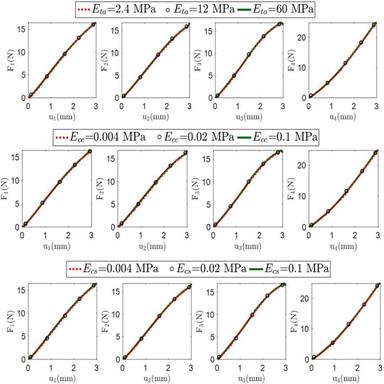
Influence of the mechanical properties of Tunica Albuginea (TA) (first row), Corpus Cavernosum (CC) (second row), and Corpus Spongiosum (CS) (third row) on the overall response of the penis in the indentation test.